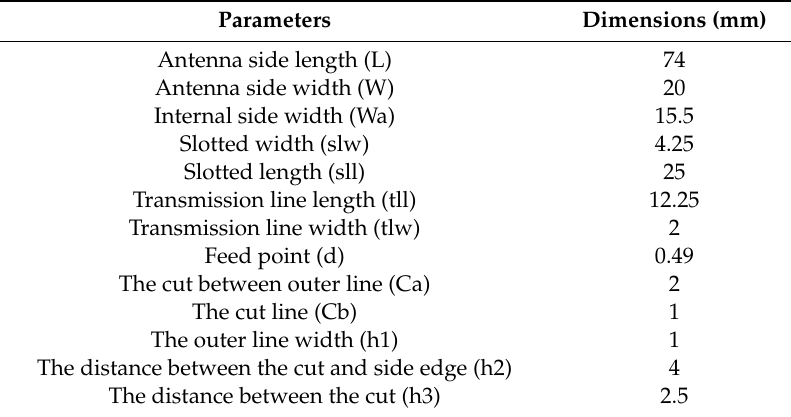
Table 1. Antenna